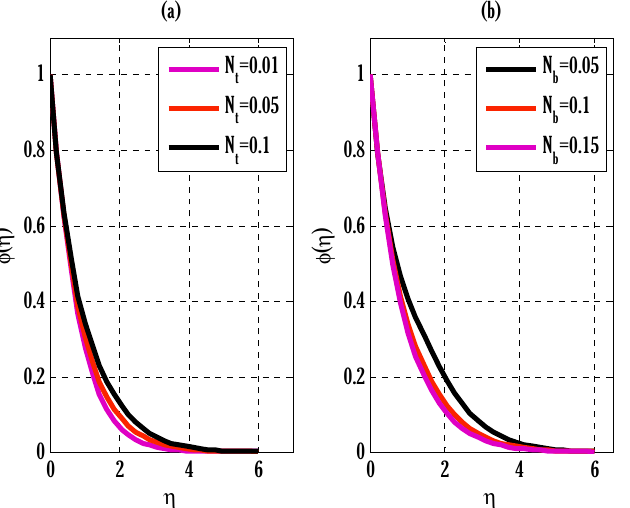
Figure 6. Variation of thermophoresis and Brownian motion parameters on concentration profile using N = 30, β = 3, λ = 0.1, F r = 0.1, M = 0.1, E 1 = 0.01, Bi = 0.1, E c = 0.3, R d = 0.1, P r = 1.7, S c = 1.5, and γ = 0.9. ( a ) N b = 0.1, ( b ) N t =